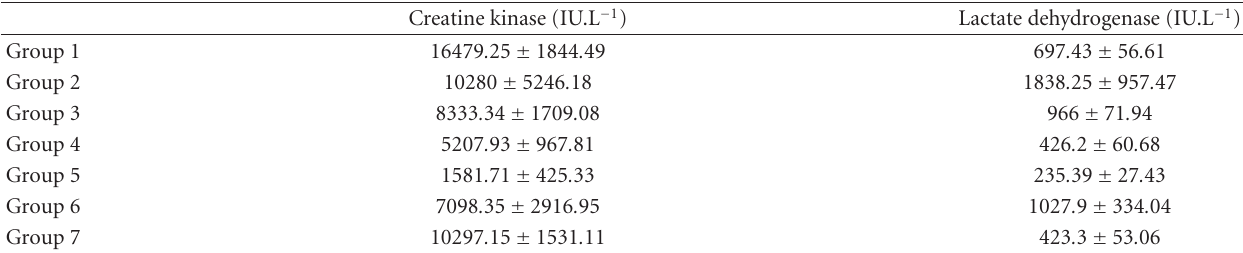
Table 4: Blood serum enzymes in di ff erent fish groups (Mean ±